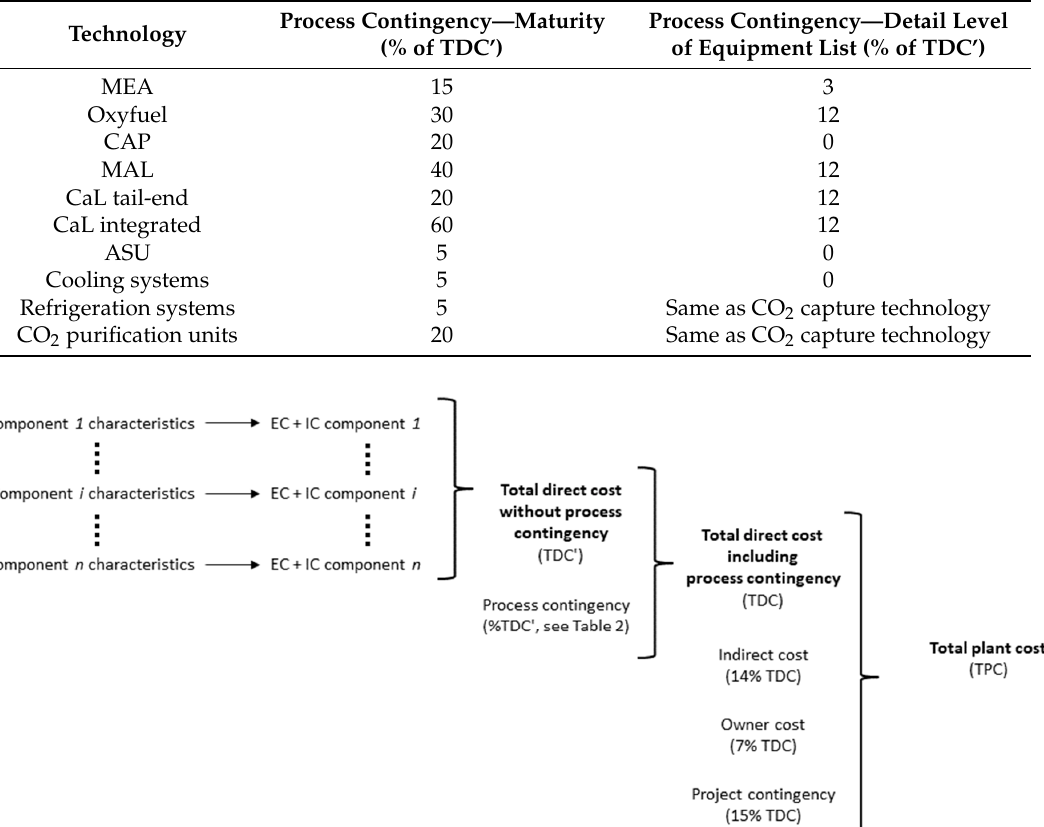
Table 3. Process contingency factors for core CO 2 capture technologies and miscellaneous subsystems.